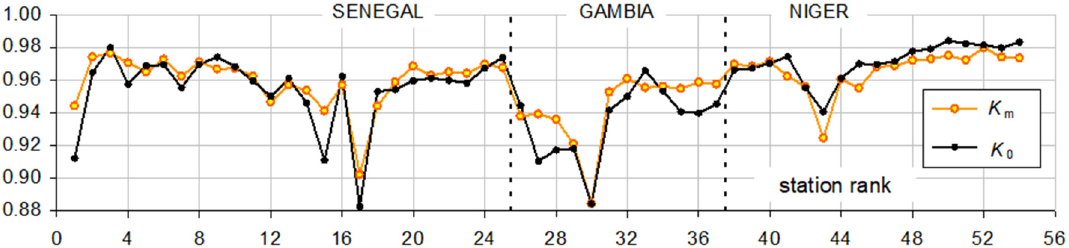
Figure 9. Mean K m of K observed and optimal value K 0 maximizing the efficiency coefficient C NSE2 of the N t discharge forecasts made with model 0 (Maillet) at horizons H between 1 and 120 days.